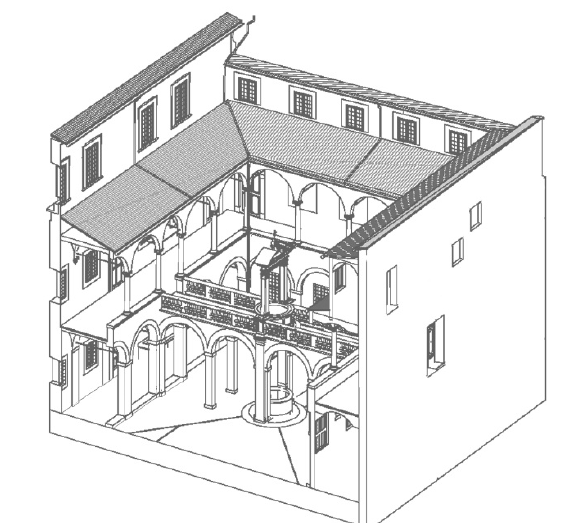
Figure 11. The Grand-Ducal cloister visualized in Autodesk